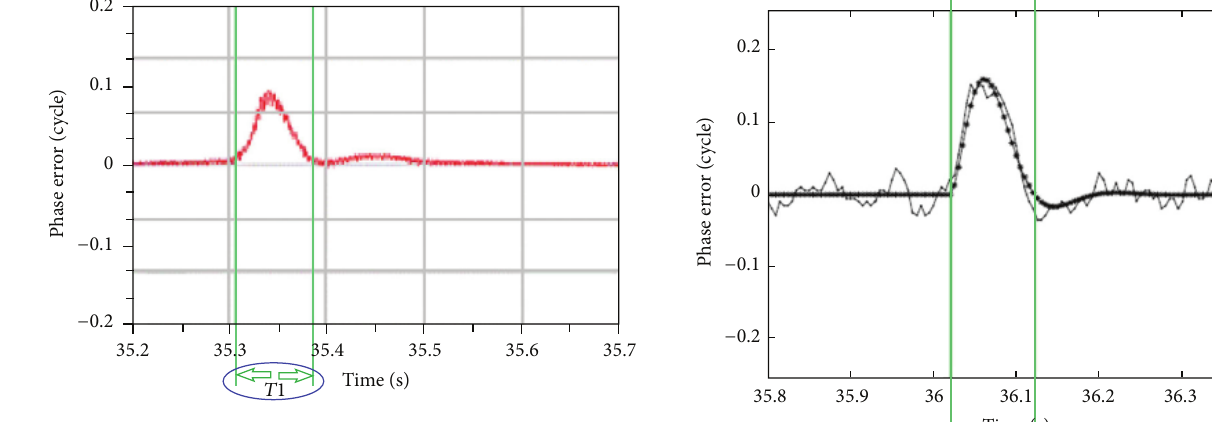
Figure 4: Phase error in proposed design during the 10g steps.